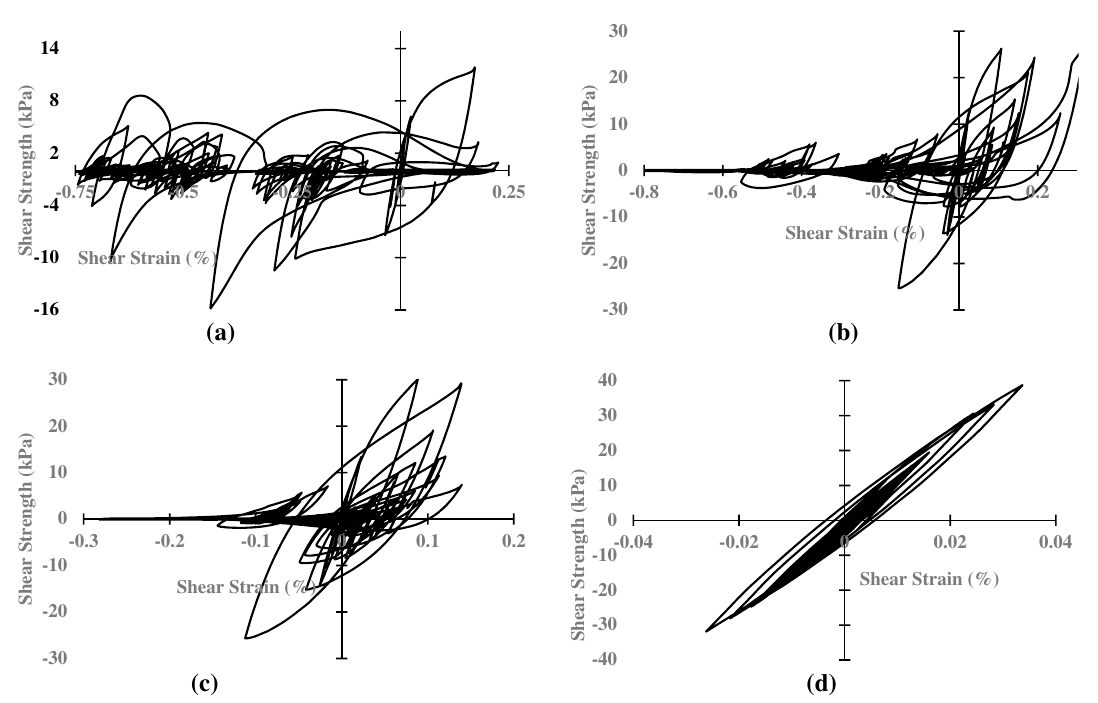
Fig. 12 Shear stress vs shear strain relationship for RCD soil under scaled IMV motion a 4.63 m b 9.53 m c 11.16 m and d 19.58 m